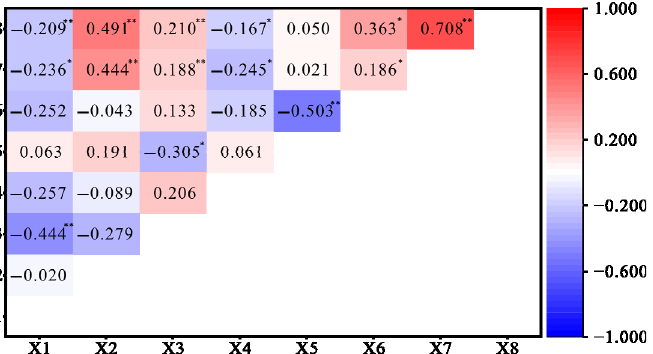
Figure 5. Pearson correlation coefficients of soil calcium with environmental factors and soil prop- erties. X1: Soil bulk density. X2: Soil pH. X3: Soil organic matter. X4: Vegetation cover. X5: Soil thickness. X6: Rock exposure rate. X7: Total soil calcium. X8: Soil exchangeable calcium. Pearson correlation was significant (* p < 0.05; ** p < 0.01).